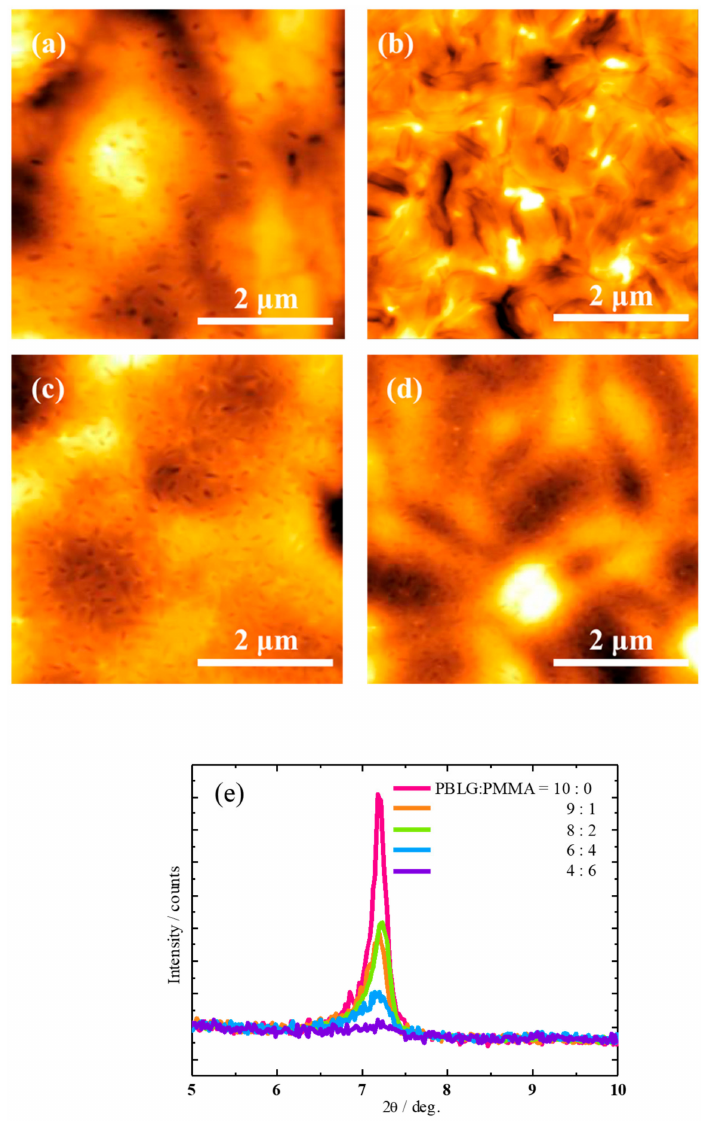
Figure 8. ( a – d ) AFM images of PBLG / PMMA films with di ff erent PBLG / PMMA ratios spun on ITO substrates. The PBLG / PMMA ratios are ( a ) 9:1, ( b ) 8:2, ( c ) 6:4, ( d ) 4:6. In all AFM images, the scale bar presents 2 µ m. ( e ) X-ray di ff raction patterns of the blend